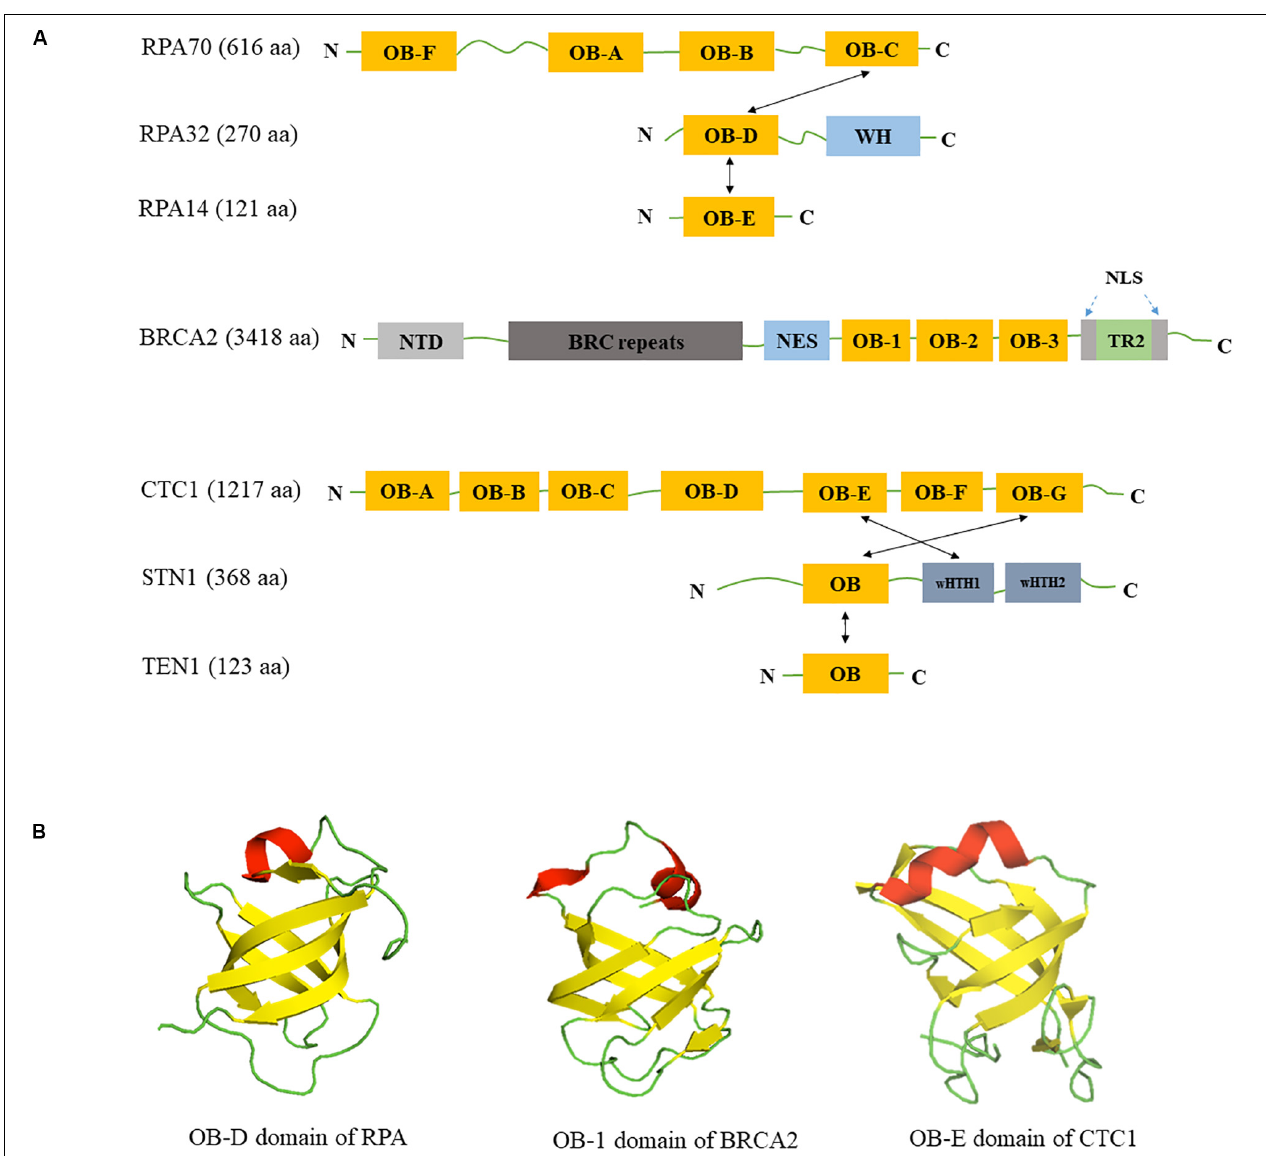
FIGURE 1 | Domain structures of RPA, BRCA2, CST. (A) Domain structures of RPA, BRCA2, and CST. OB: OB-fold domain; WH: winged helix domain; NTD: N-terminal domain; BRC repeats: BRCA2 exon 11 encodes eight conserved motifs; NES: nuclear export signal domain; NLS: nuclear localization signals; TR2: the single RAD51-binding domain; wHTH: winged helix-turn-helix domain; Black arrows show the intermolecular interactions between subunits. (B) Similarity of OB-fold structures in RPA, BRCA2 and CST. OB folds are β barrels formed by five antiparallel β -sheets. β -strands are colored in yellow, α -helices are colored in red and loops are colored in green. Structures are derived from Protein Data Bank with structure codes 1L1O (RPA), 1IYJ (BRCA2), and 5W2L (CTC1).